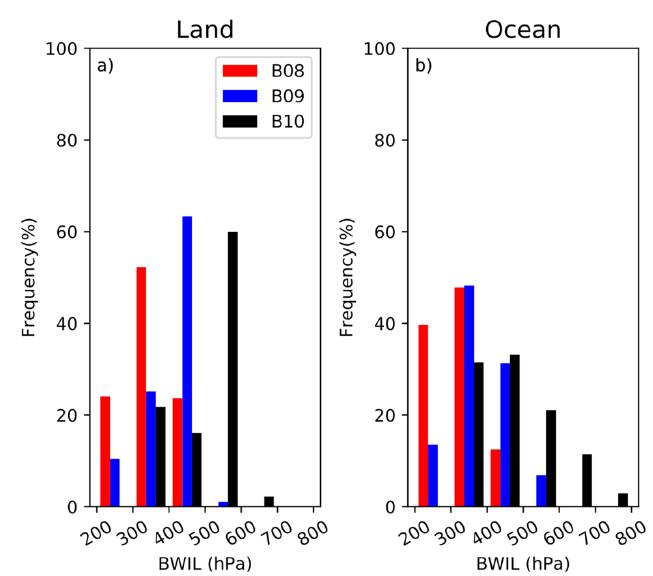
Figure 10. ( a ) The frequency of distribution of the height (hPa) of BWIL over the land for Band 8, Band 9 and Band 10. ( b ) The frequency of distribution of the height (hPa) of BWIL over the sea for Band 8, Band 9 and Band 10.